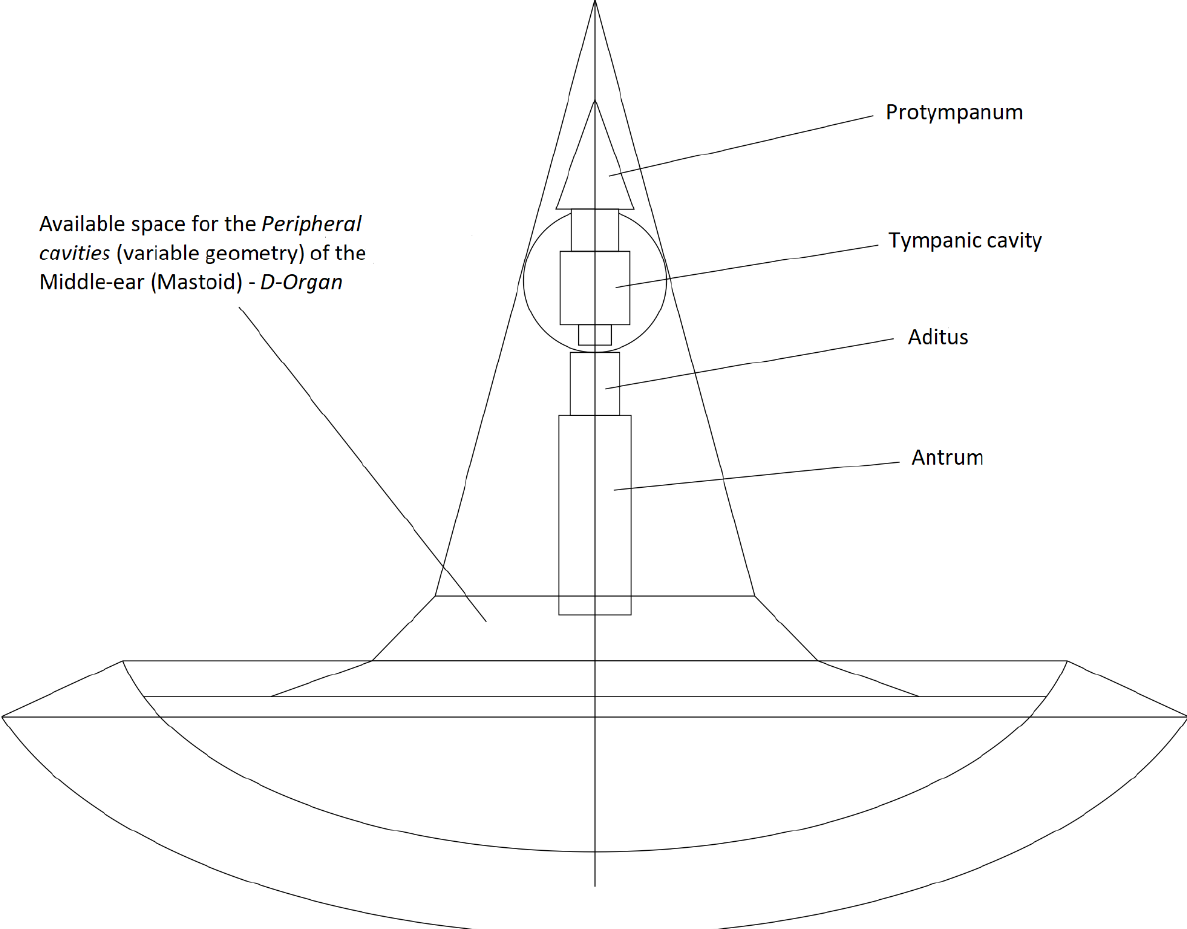
Figure 7. Three-dimensional rapport between the temporal bone of the adult and the fixed geometry middle-ear cavities, on an axial section of the two regular geometric coaxial compound bodies. The image defines within the section plan the space available for the existence of the middle-ear peripheral cavity system (mastoid and petrous), also defined as the space available for the existence of variable geometry middle-ear (Danaid Organ).